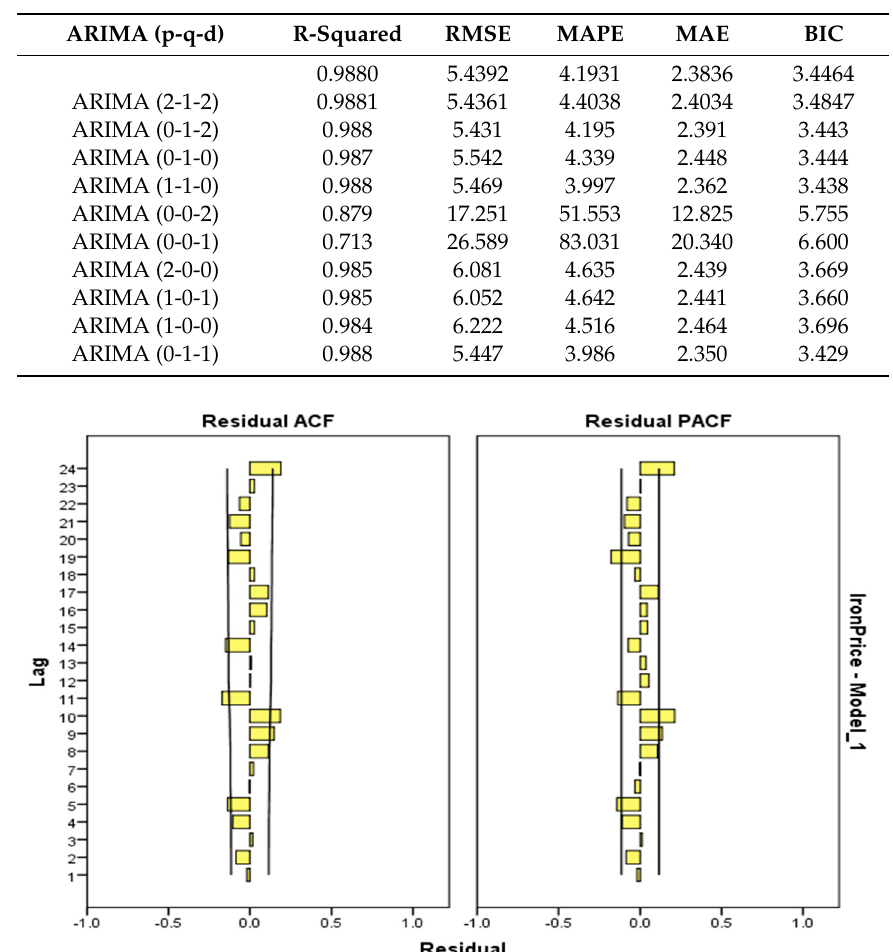
Figure 3. Residual plots of (ACF) and (PACF) by using ARIMA (0-1-1).